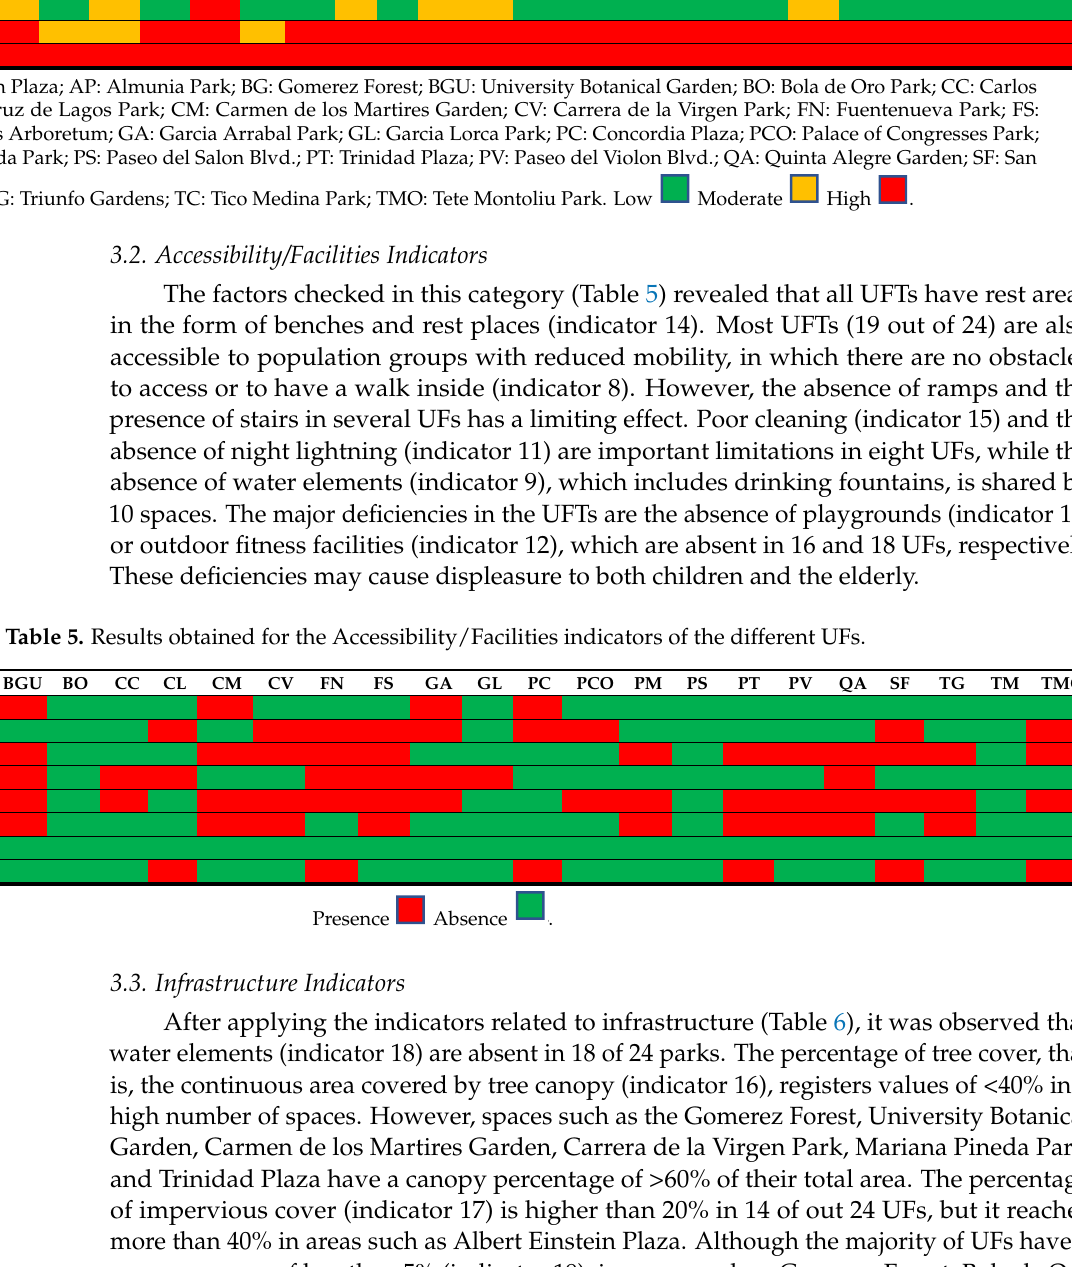
AE: Albert Einstein Plaza; AP: Almunia Park; BG: Gomerez Forest; BGU: University Botanical Garden; BO: Bola de Oro